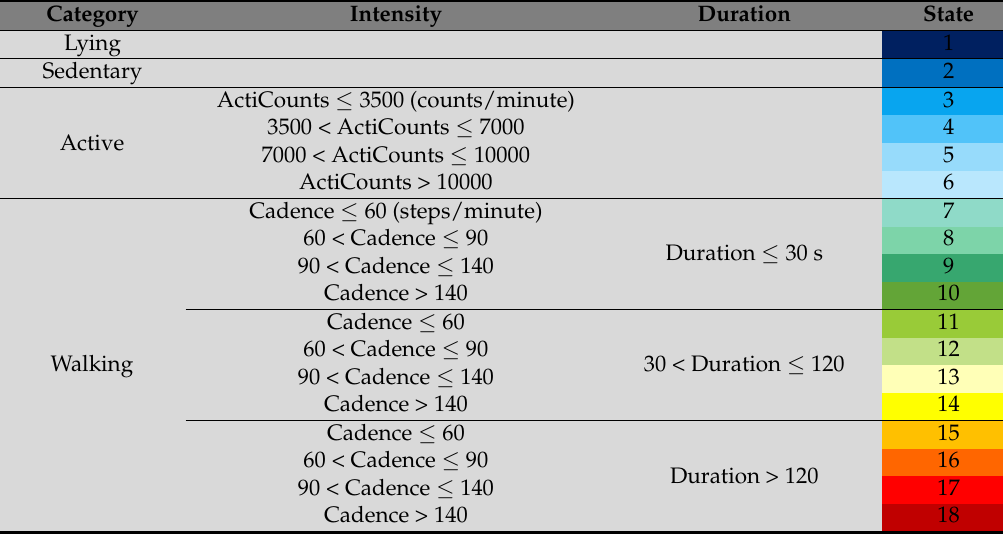
Table A1. Definition of barcode state according to PA category, intensity and duration.